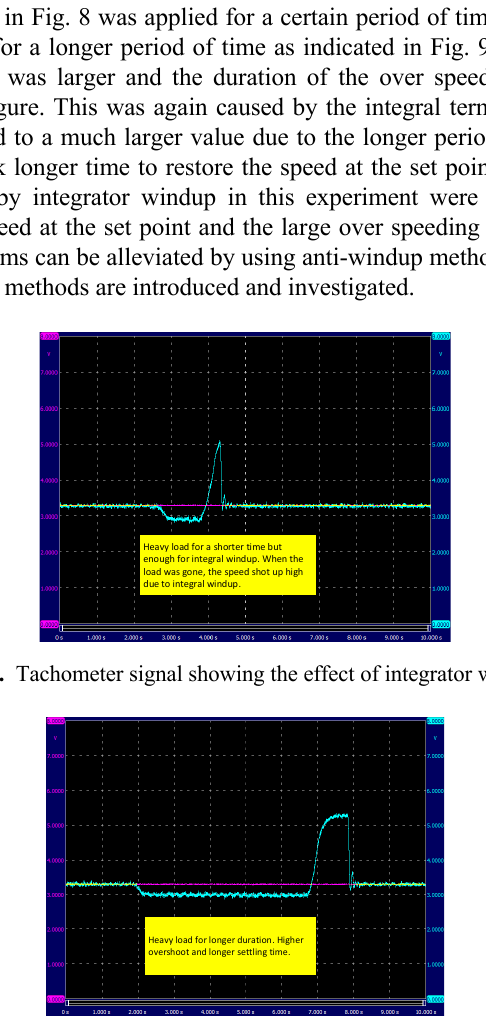
Fig. 9. Tachometer signal due to heavy load applied for longer duration